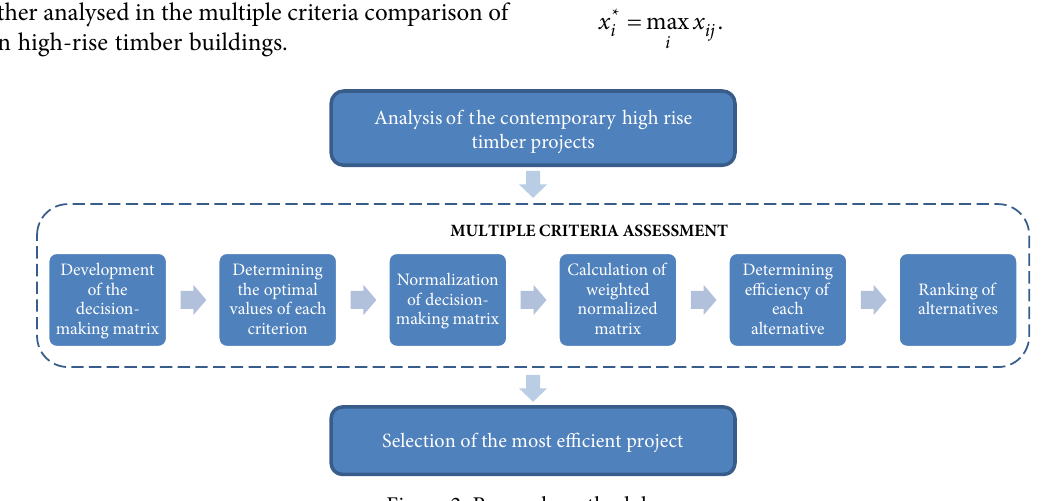
Figure 2. Research